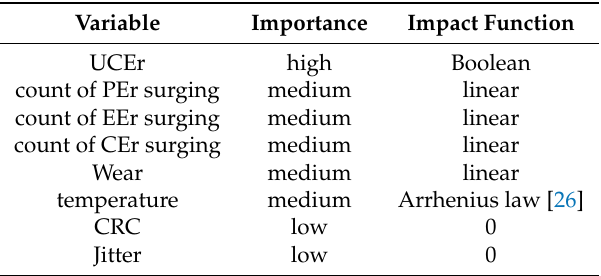
Table 8. Variables in iLife and their relative importance. The last column shows the type of impact function applied to the variable. A “0” impact function means the variable is not used to determine the lifetime. Variable Importance Impact Function UCEr high Boolean count of PEr surging medium